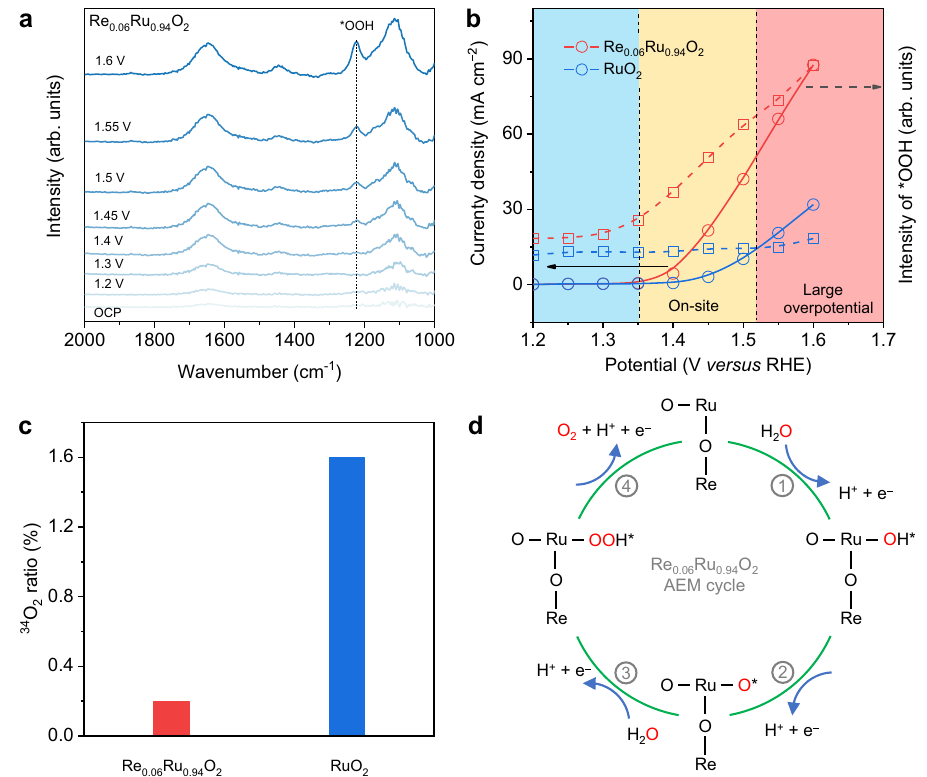
Fig. 4 | Reaction mechanism on Re 0.06 Ru 0.94 O 2 and RuO 2 . a In situ ATR-SEIRAS spectrafor Re 0.06 Ru 0.94 O 2 during multi-potential steps. b Potential dependenceof band intensity of characteristic vibration adsorption of surface-adsorbed *OOH.